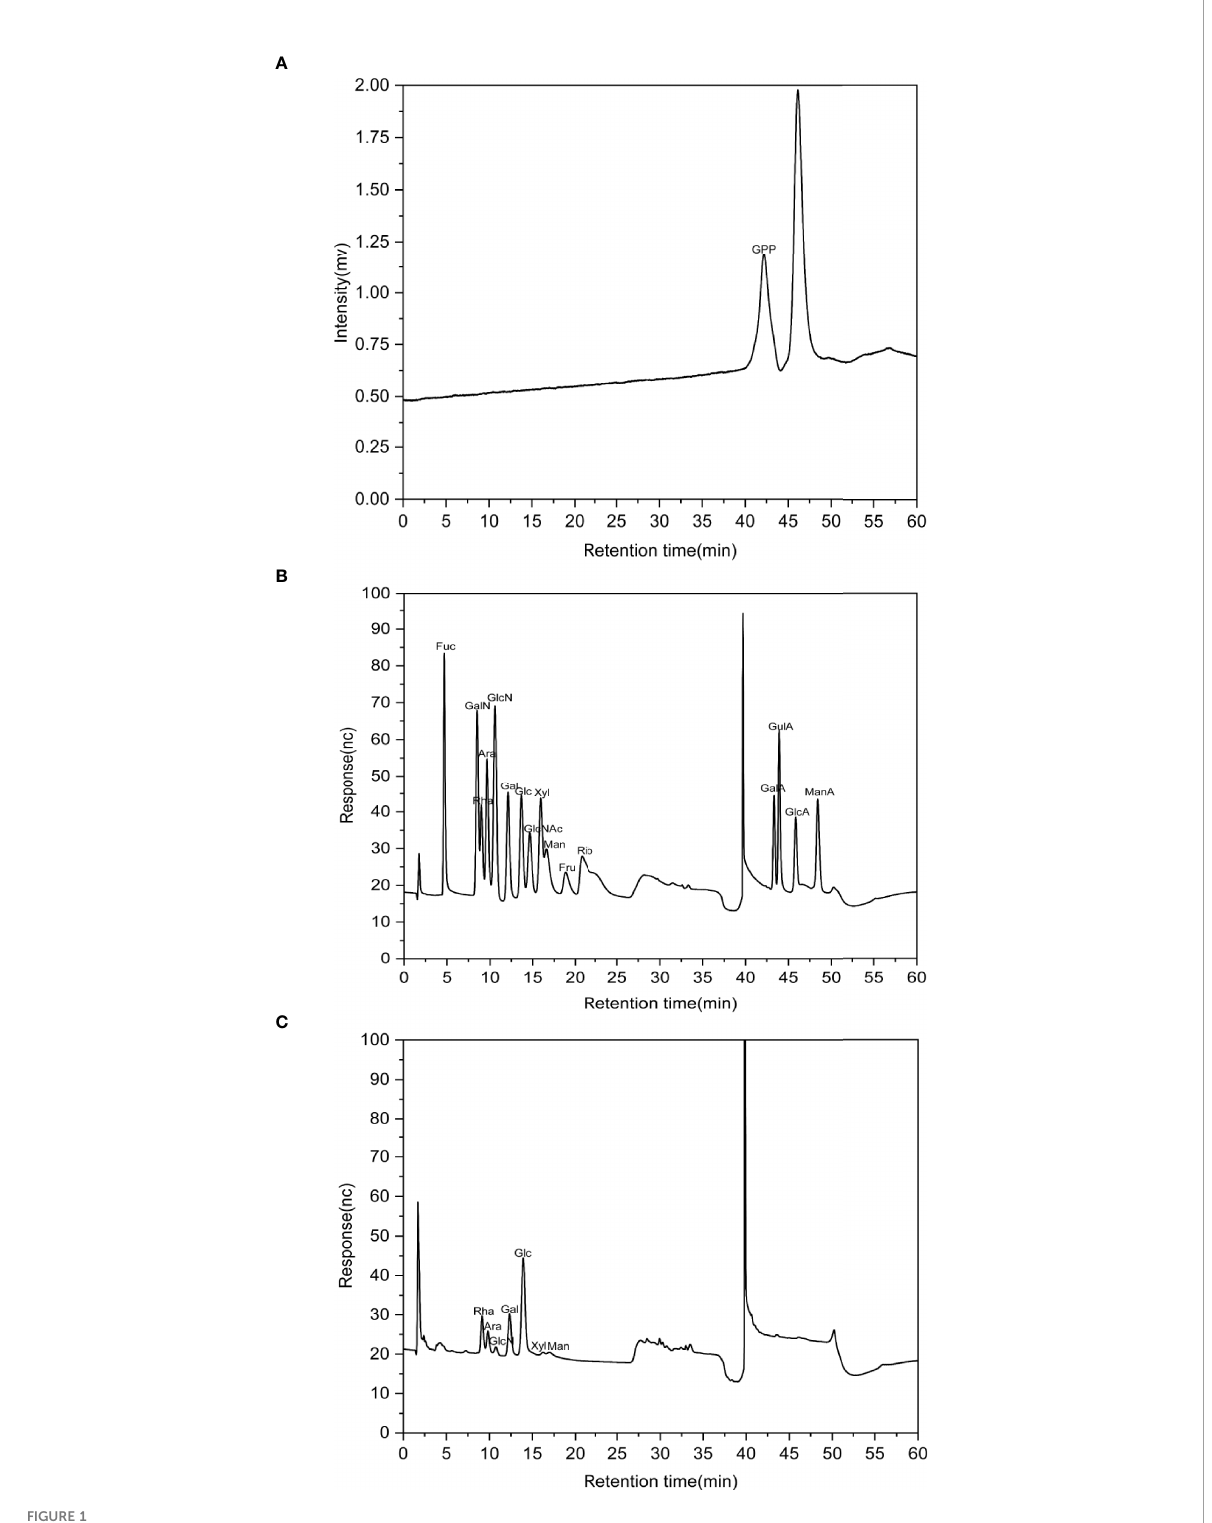
FIGURE 1 The characterization of Gynostemma pentaphyllum polysaccharides (GPP). (A) High-performance gel permeation chromatography (HPGPC) chromatogram of GPP. (B) Ion-exchange (IC) chromatograms of standard monosaccharides and (C) component monosaccharides of